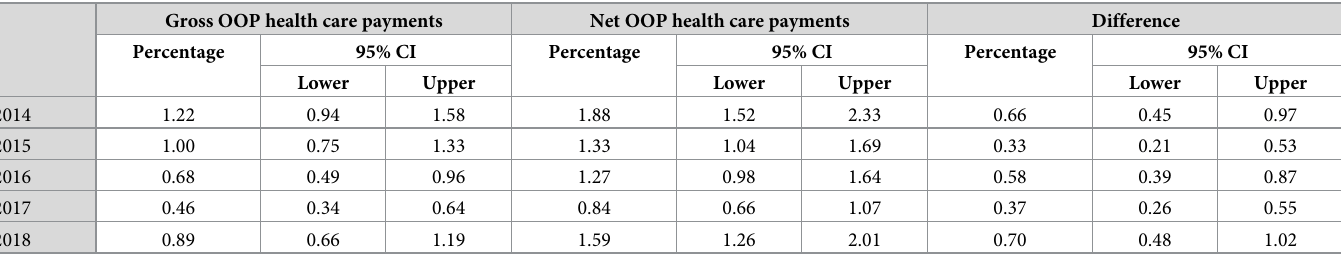
Table 4. Trends in the poverty headcount and poverty gap before and after OOP payments for health in Armenia between 2014 and 2018 using the US$1.90 per per- son per day international poverty line. Gross OOP health care